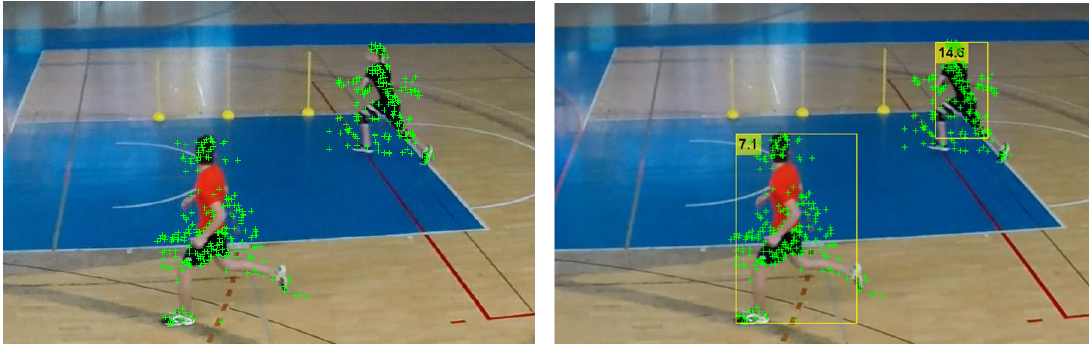
Figure 6. Fusion of bounding box and spatiotemporal interest